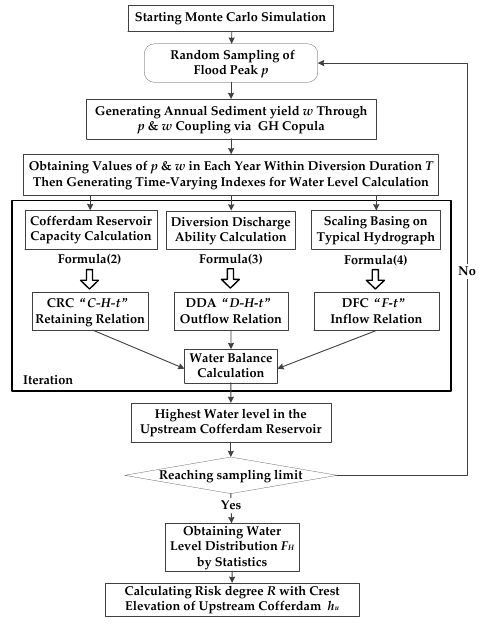
Figure 3. Working process of the CDR assessment method.